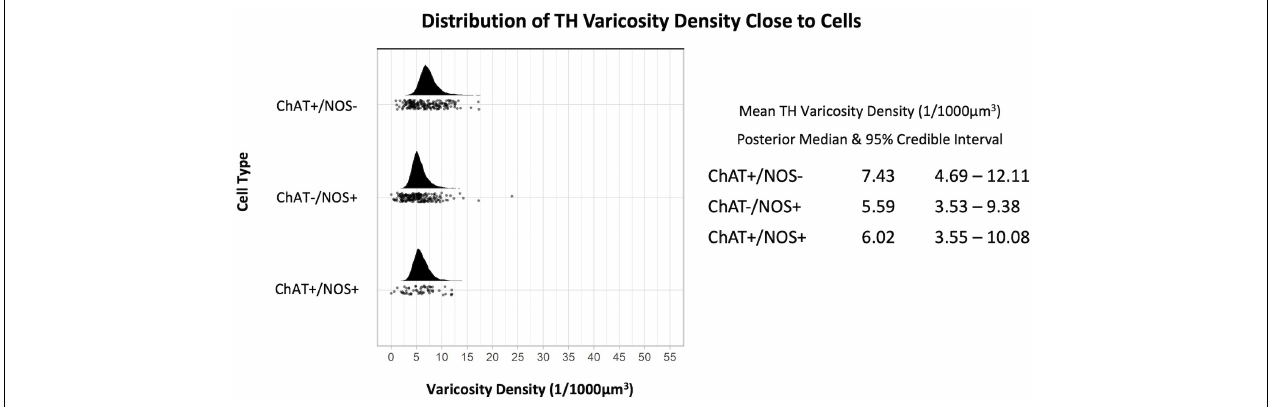
FIGURE 3 | Graph of the distribution of tyrosine hydroxylase varicosities close to cells. The upright curve in each graph is the distribution of the mean density for each cell type. Every small black dot beneath represents the density of TH varicosities close to an individual cell. The posterior median of the mean varicosity density is greatest for the ChAT +/NOS– cell type at 7.43 varicosities per 1,000 µ m 3 . The posterior median of the mean TH varicosity density for each cell type is presented with the 95% credible intervals on the right. ChAT, choline acetyltransferase; NOS, nitric oxide synthase; TH, tyrosine hydroxylase.